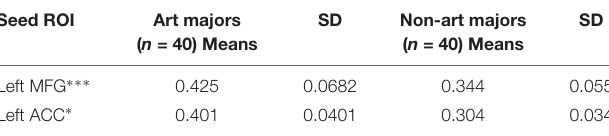
TABLE 4 | Independent sample t -test analysis with active regions as seeds. Seed ROI Art majors ( n = 40) Means